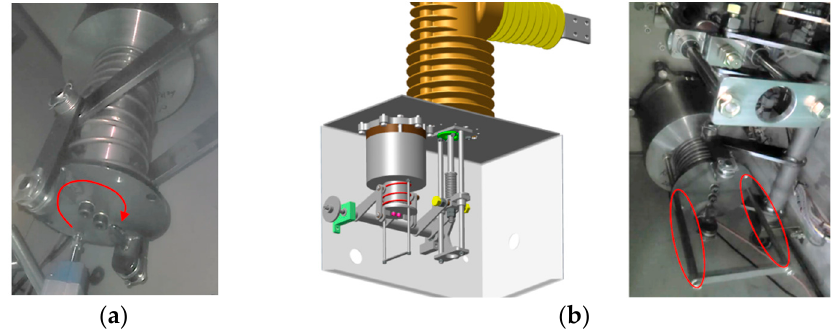
Figure 15. ( a ) PMA plunger rotation structure and ( b ) design of a plunger anti-rotation structure.